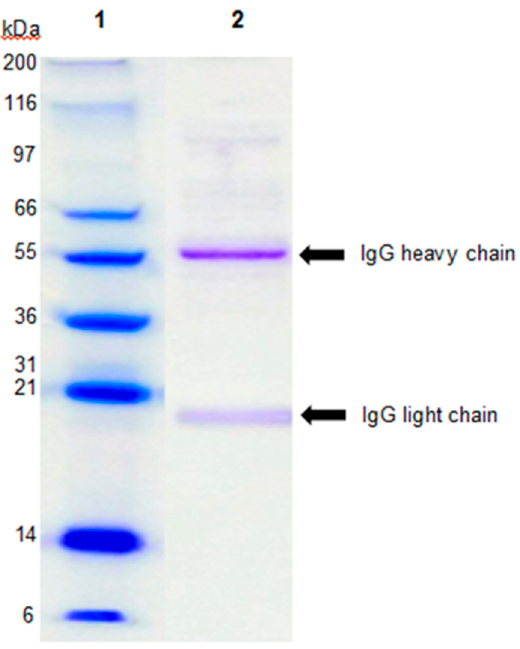
Figure 1. Protein characterization of the IgG-enriched powder (IGEP) by NuPAGE 4–12% SDS-PAGE separation with Coomassie Blue staining. Lane 1, molecular mass marker; Lane 2, reduced IGEP.